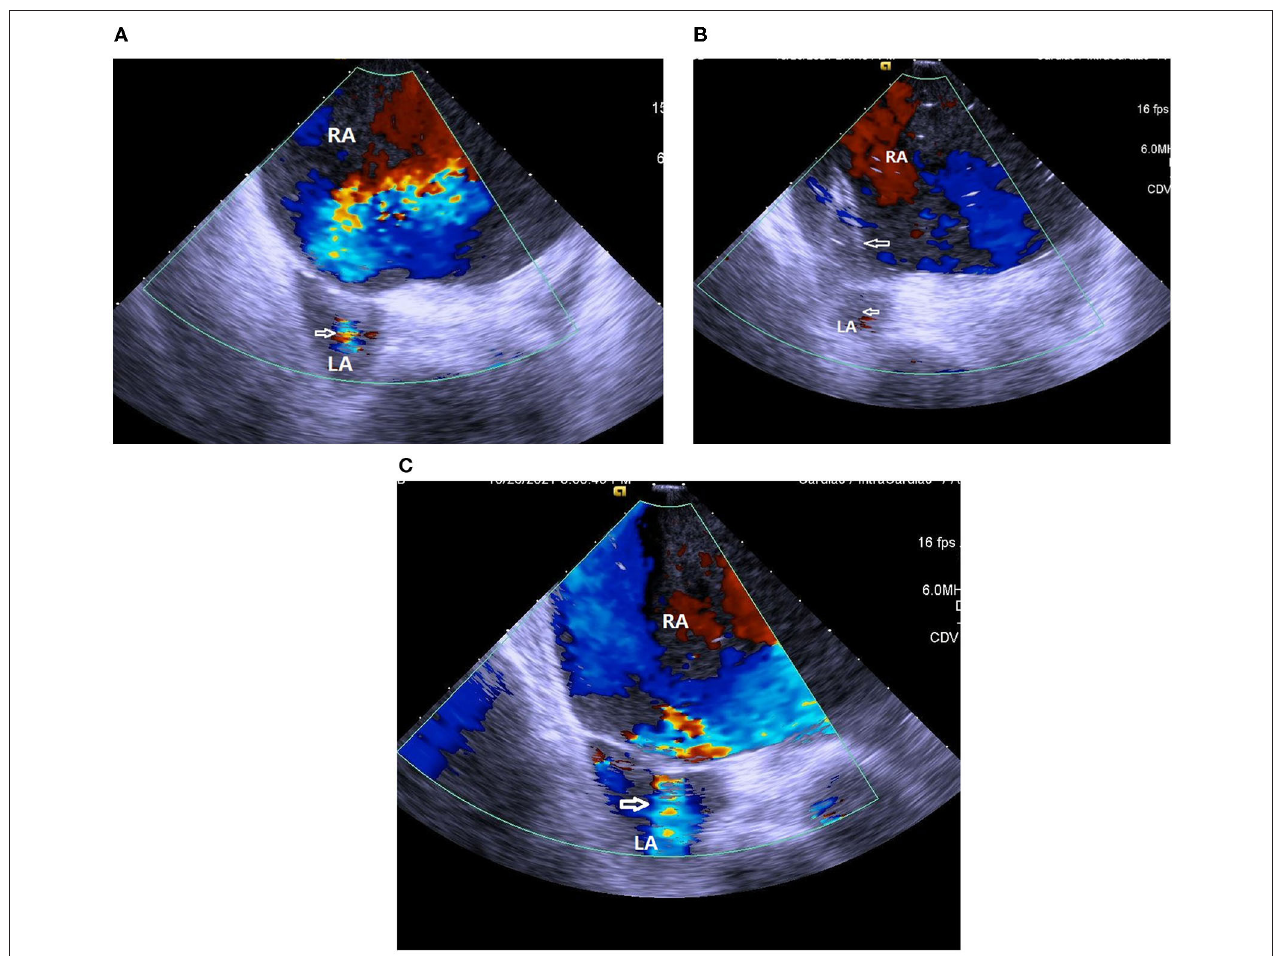
FIGURE 2 | (A) ICE confirmed the presence of interatrial shunting (white arrow) created by previous balloon atrial septostomy. RA, right atrium; LA, left atrium. (B) ICE showed inflation of an 8mm balloon (white arrows) at the second session of balloon atrial septostomy. RA, right atrium; LA, left atrium. (C) ICE showed an increase of right to left shunting (white arrow) after second session of balloon atrial septostomy. RA, right atrium; LA, left